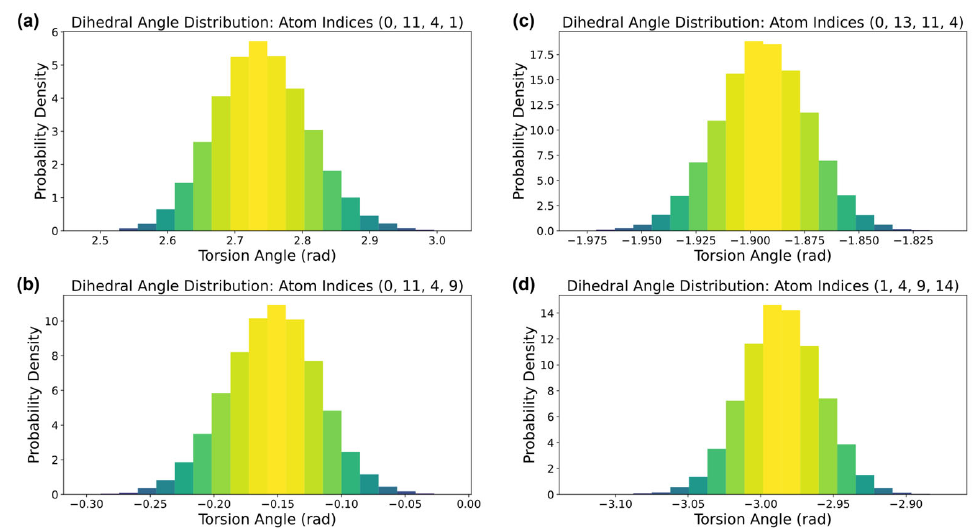
Figure A1. Randomly selected examples of torsion angle distributions for 4 dihedrals of atom indices of ( a ): (0, 11, 4, 1); ( b ): (0, 11, 4, 9); ( c ): (0, 13, 11, 14); and ( d ): (1, 4, 9, 14).